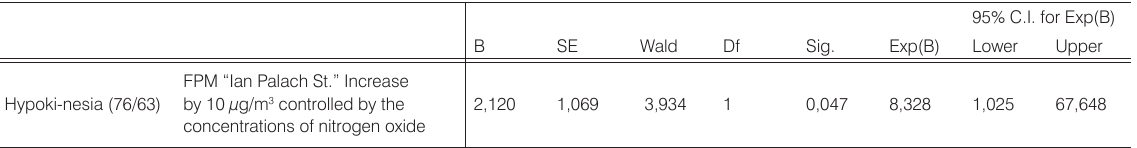
Table 6. Odds ratio for AMI in people, working in hypokinetic state in the days with increased concentrations of FPM “Ian Palach St.”, by controlling the concentrations of nitrogen